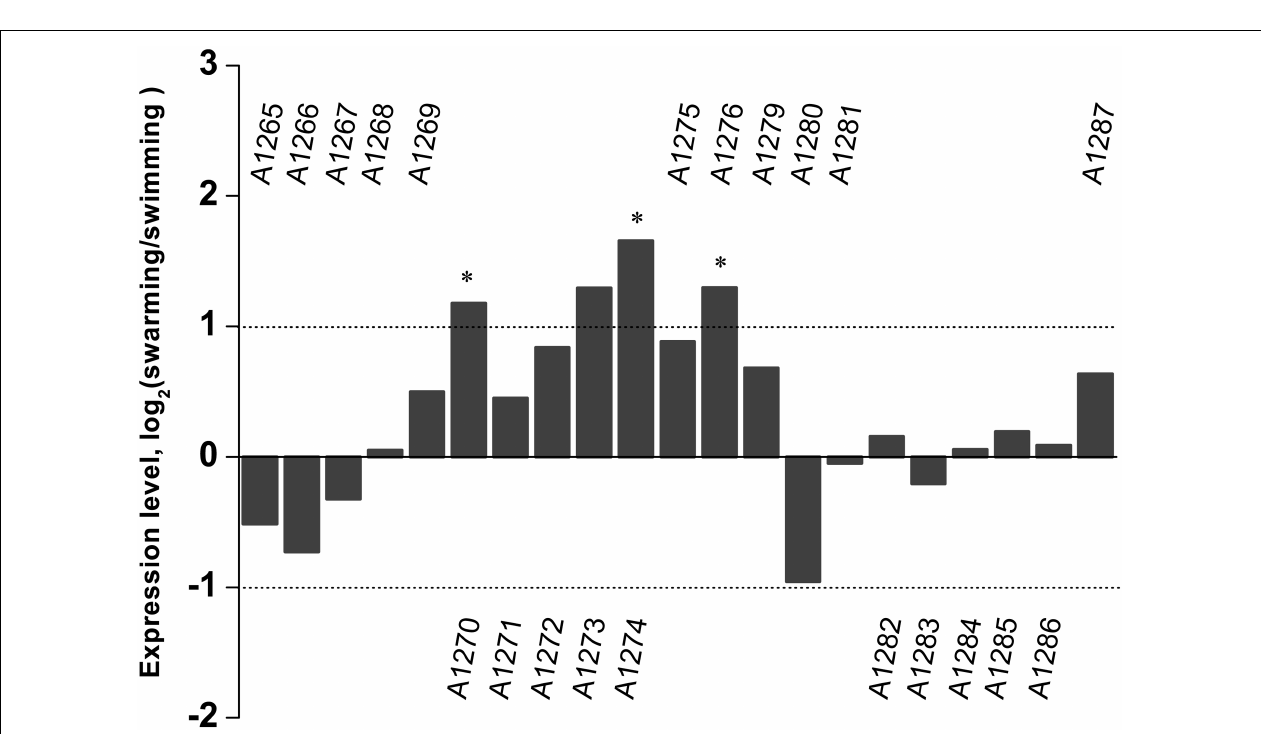
FIGURE 3 | The relative expression levels of genes belonging to the EPS gene cluster between swarming and swimming cells of SM9913 based on transcriptome data. Differentially expressed genes were indicated by the symbol ∗ . A gene was regarded as a differentially expressed gene when its | log 2 (swarming/swimming )| ≥ 1 (demarcated by dot lines) and its P ≤ 0.001. Gene PSM_A1273 was not regarded as a differentially expressed gene because its P -value was greater than